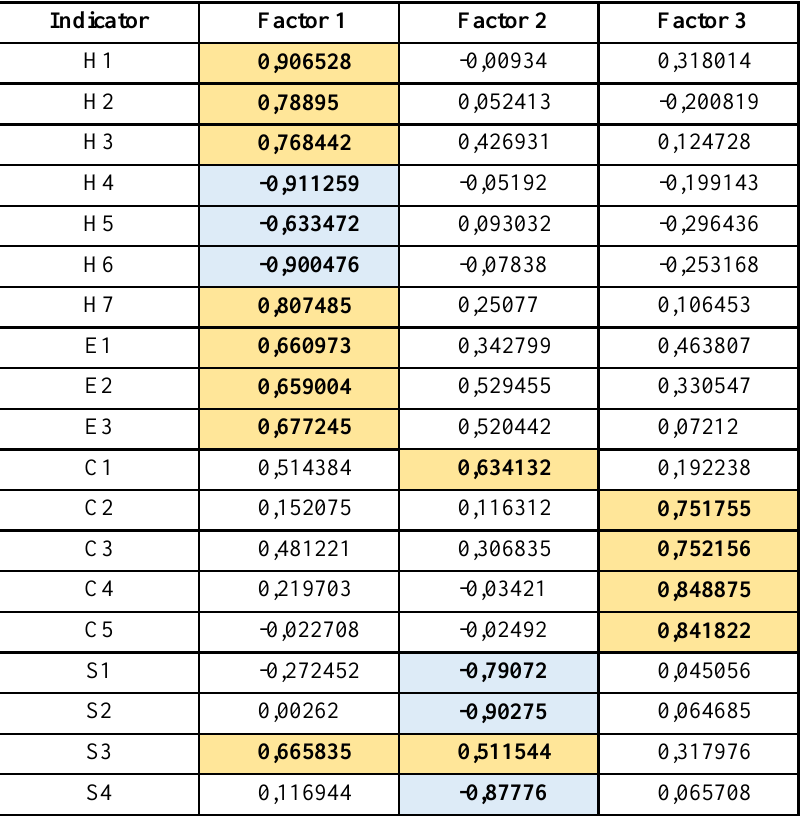
Table 2. Factor loadings Matrix After Varimax Rotation.